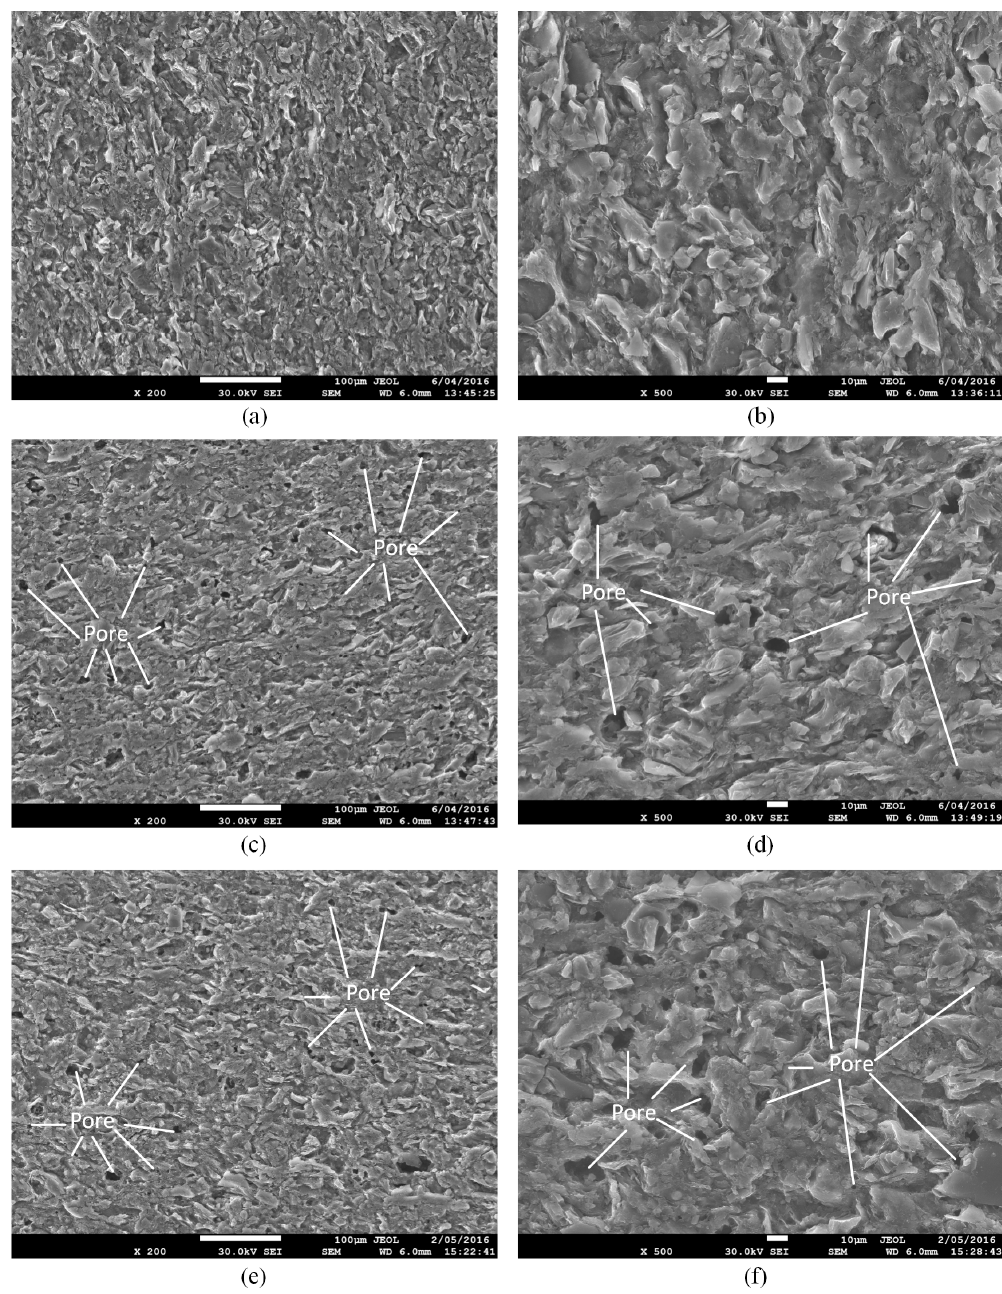
Figure 3. SEM images of of samples without saturation ( a , b ); samples with water + gaseous CO 2 saturation ( c , d ) and samples with water + super-critical CO 2 saturation ( e , f ). ( a , c , e ) have a magnification of 200×; ( b , d , f ) have a magnification of 500×.